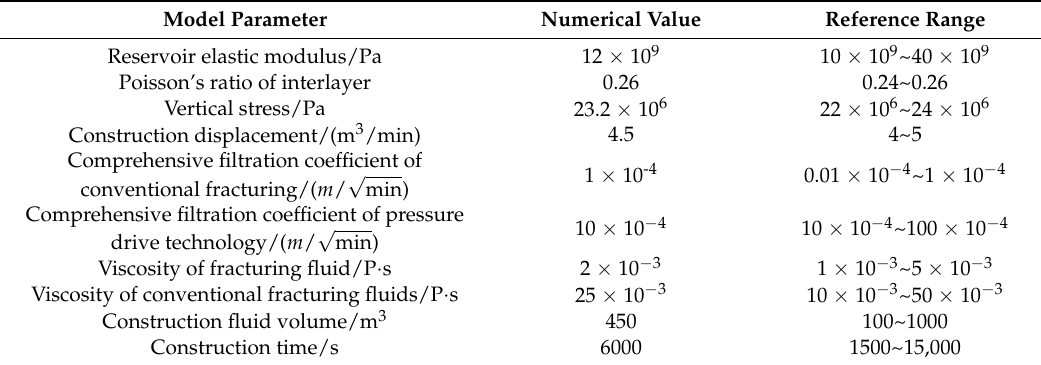
Table 1. Calculation of model